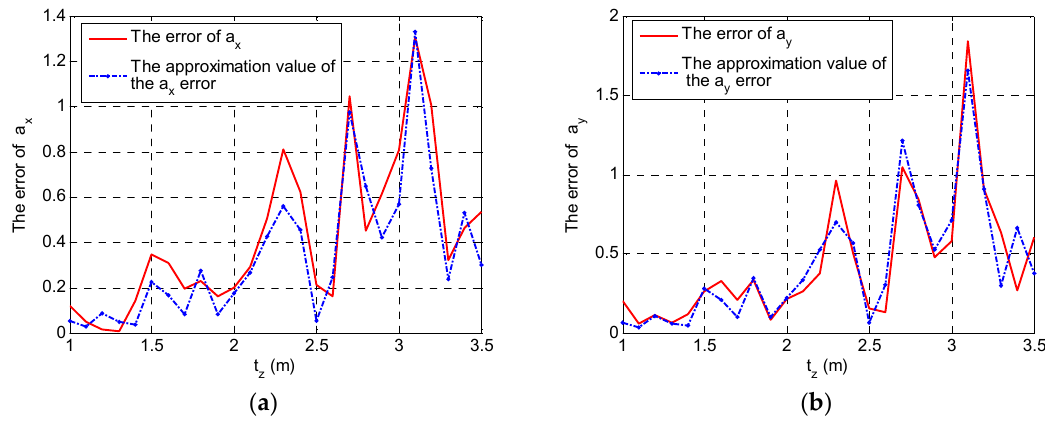
a error comparison. a error comparison; ( b ) y x